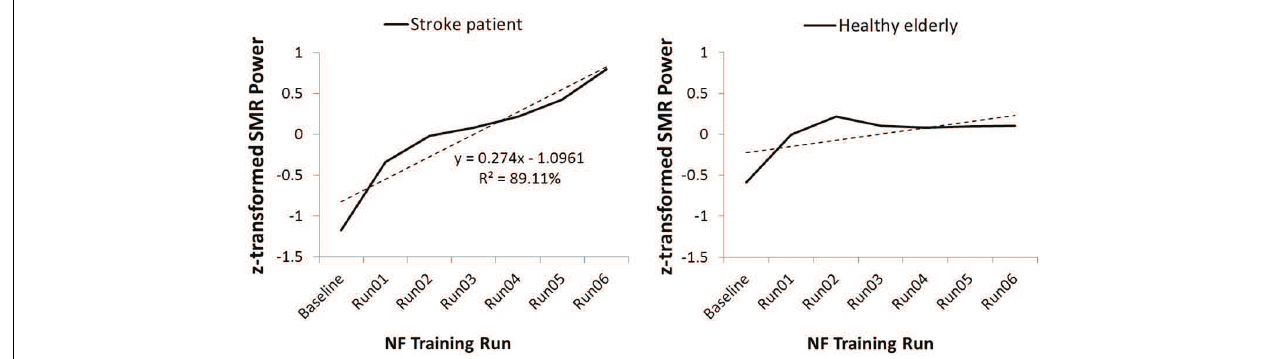
FIGURE 2 | Time course of sensorimotor rhythm (SMR) power over the neurofeedback training runs, averaged over all 10 NF training sessions, in stroke patient UG20 and in the healthy elderly group.